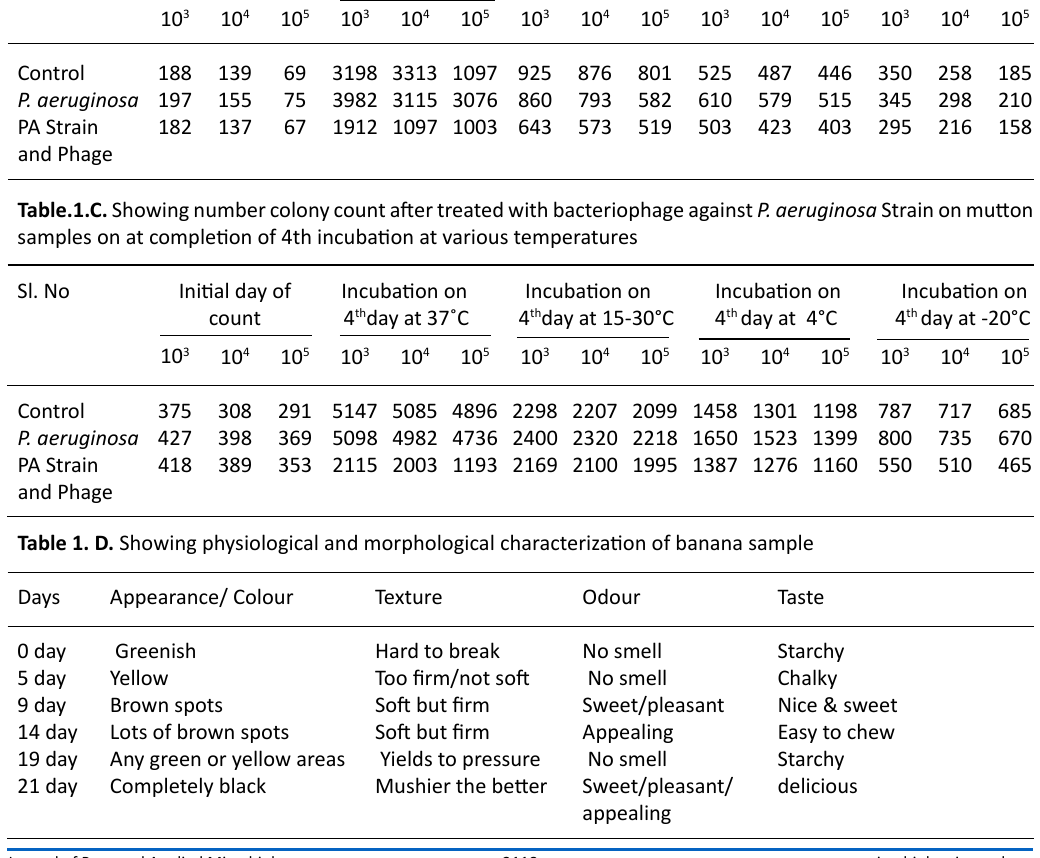
Table 1.B. Showing number colony count after treated with bacteriophage against P. aeruginosa Strain on chicken samples on a completion of 4th incubation at various temperatures Sl. No Initial day of